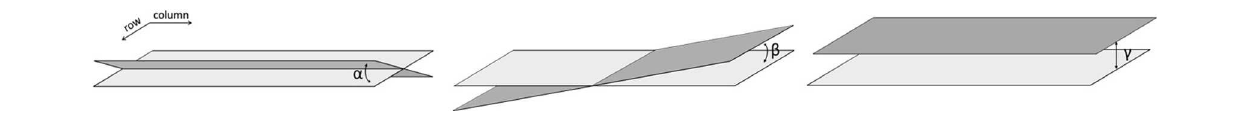
FIGURE 4 | Visualization of the parameters alpha, beta, and gamma of a plane.